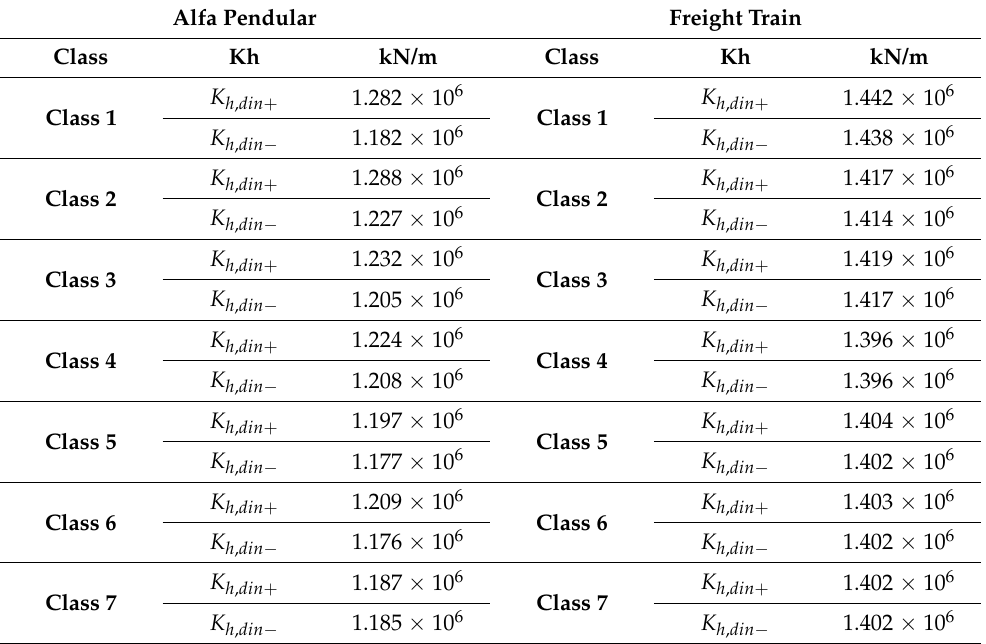
Table 4. Contact stiffness for maximum and minimum dynamic loads. Alfa